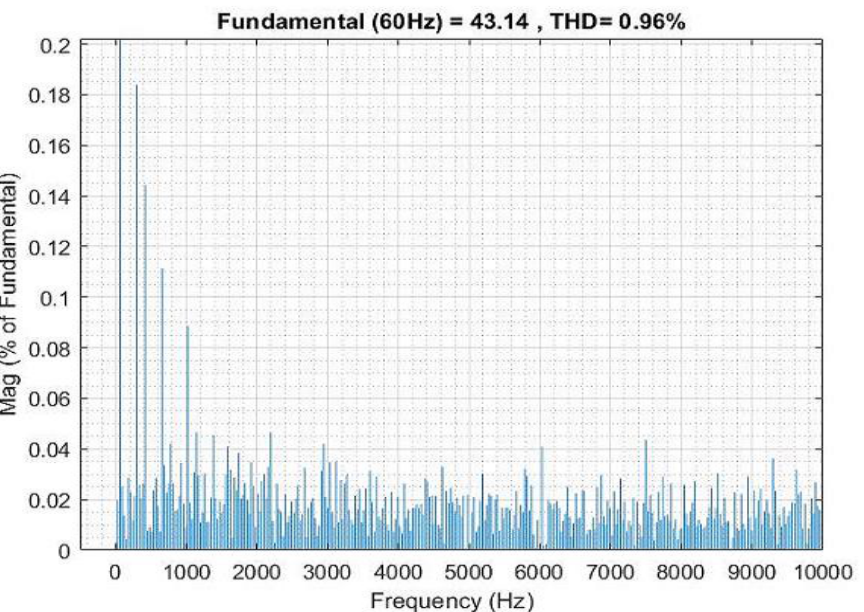
Figure 9. %THD of current for the two-step horizon prediction for single DG connected in grid- connected mode.